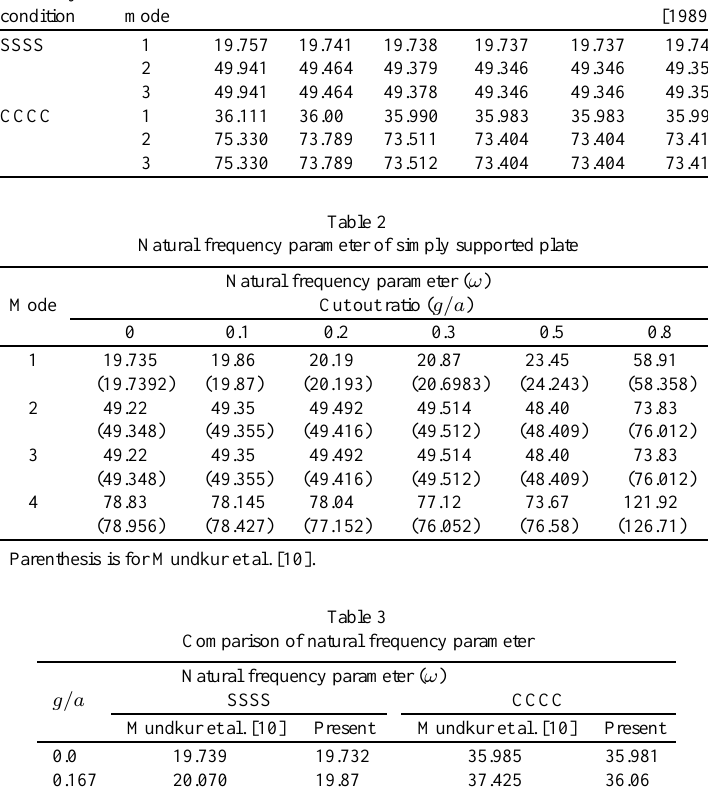
Convergence of frequency parameter for isotropic square plate Boundary